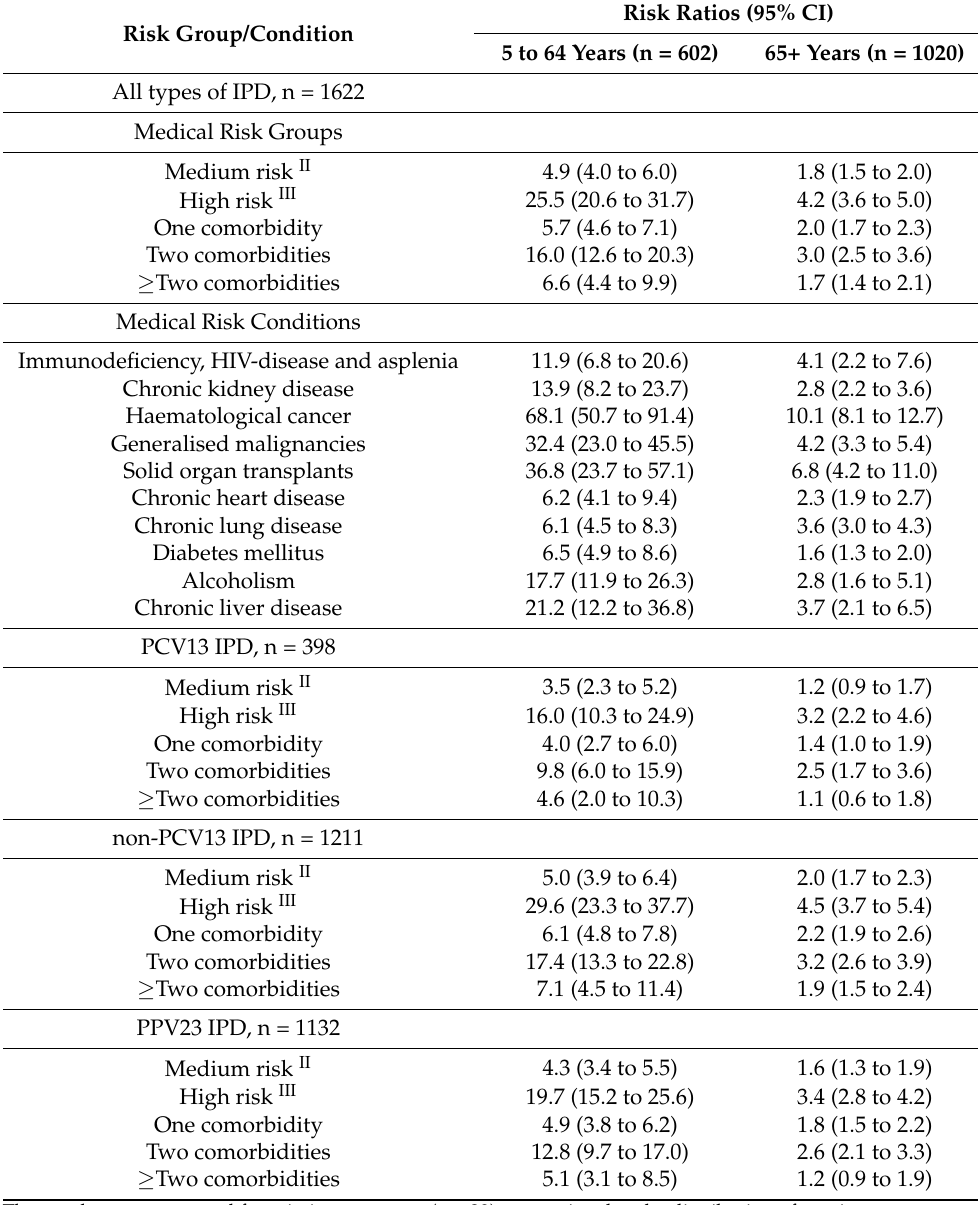
Table 2. Risk ratios between medical risk groups and those with no medical risk by risk strata, age and vaccine group in Norway, 2015 to 2017 (n =